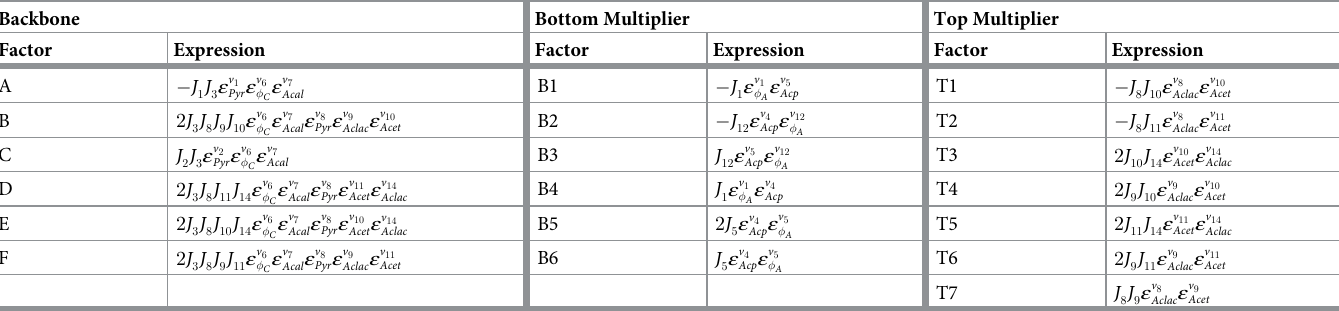
Backbone expressions are named A–F and multipliers are classified according to their relative position on the reaction scheme, with B and T multipliers appearing on the bottom and top halves respectively. Each of the control pattern numerators of C J 6 is a product of one of the backbones and either a B (for backbones B, D–F) or both v 3 a B and a T multiplier (for backbones A and C). Valid control pattern numerators do not consist of multiplier-backbone combinations with overlapping factors.